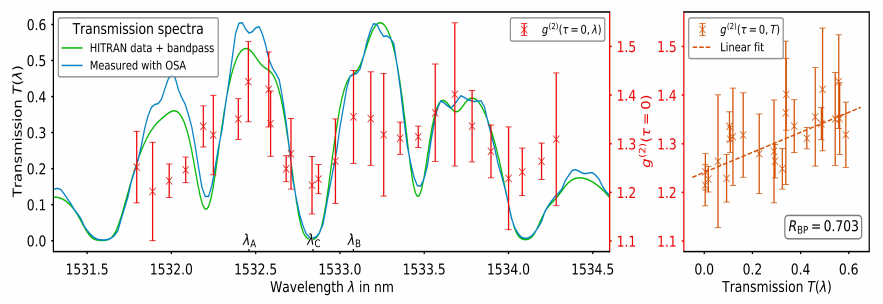
Figure 4. Left : Ghost spectrum of an absorption feature of acetylene (C 2 H 2 ) at a pressure of 200kPa around 1533nm measured with the setup of Figure 1. Conventionally measured standard absorption spectrum of acetylene (blue, left scale), corrected HITRAN transmission (green, left scale) and ghost spectrum (red, right scale) obtained via the spectral intensity correlations. The error bars correspond to the standard deviation of a set of 5 measurements. Right : Correlation between g ( 2 ) ( τ = 0, λ i ) and T ( λ i ) evaluated in terms of the BP correlation coefficient according to Equation